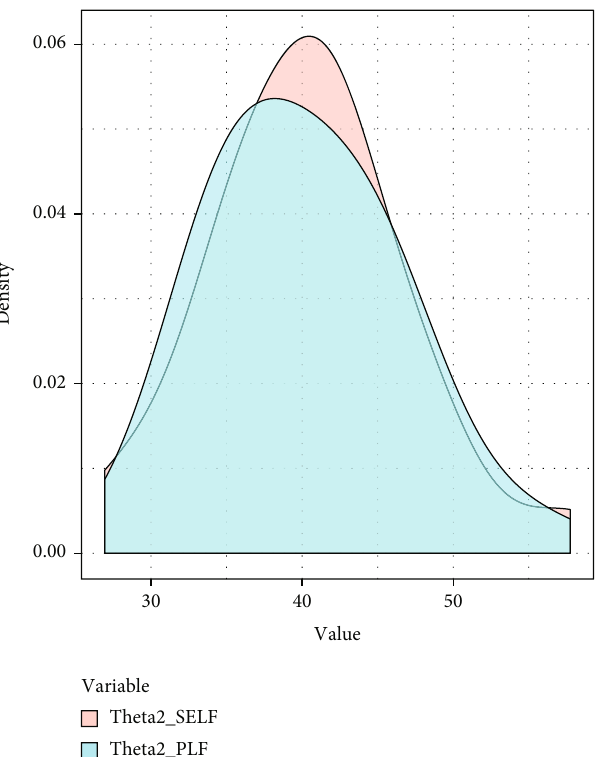
Figure 8: The marginal density for θ